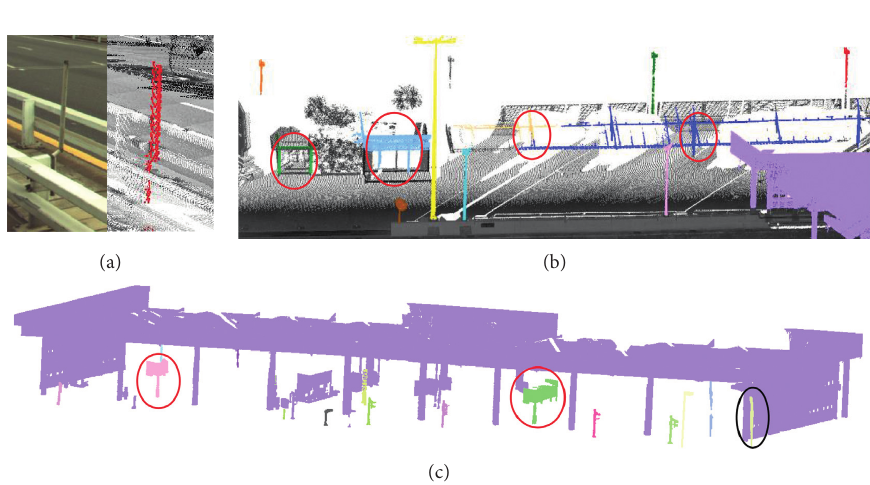
Figure 14: Incorrect PLO detection. (a) Bare poles. (b) Four building frames with their supporting columns (pole-like structures). (c) Wrongly detected tollgate and 11 objects as PLOs due to their pole-like structures (different colors indicate different detected PLOs).